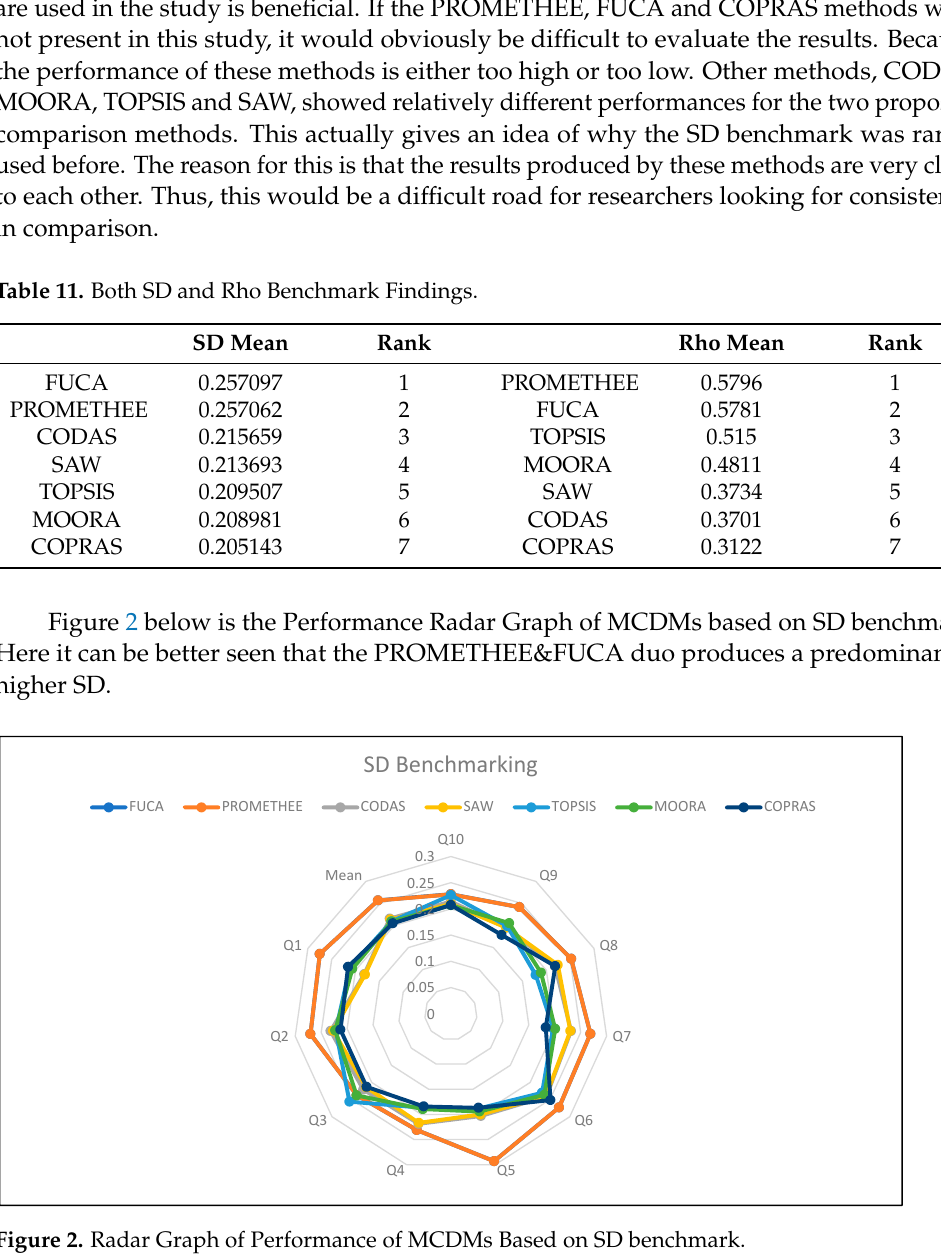
Figure 2. Radar Graph of Performance of MCDMs Based on SD benchmark. Figure 3 Below is the performance radar graph of the MCDMs based on the Rho benchmark. It can be better seen here that the PROMETHEE&FUCA duo often produces a higher Rho.